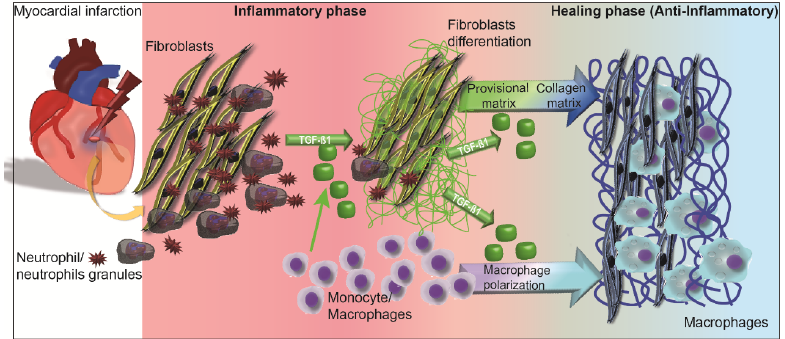
Figure 5. Sketch of healing after MI based on neutrophil-modulated fibroblast function . MI is followed by complex cellular and molecular events, in which fibroblasts proliferate, producing an initial provisional matrix (green fibers). In the inflammatory phase (red panel), the recruited neutrophils assist fibroblasts with provisional fibrin/fibronectin matrix formation (green fibers). TGF-β1 (green capsules) expressed from monocytes and neutrophil-stimulated fibroblasts leads to fibroblast fibroblasts with provisional fibrin / fibronectin matrix formation (green fibers). TGF- β 1 (green differentiation, collagen synthesis (blue fibers) and macrophage polarization, respectively. Reaching an elevated expression, a self-regulatory negative feedback is activated, reducing TGF-β1 expression, allowing the healing phase to complete the mature scar.